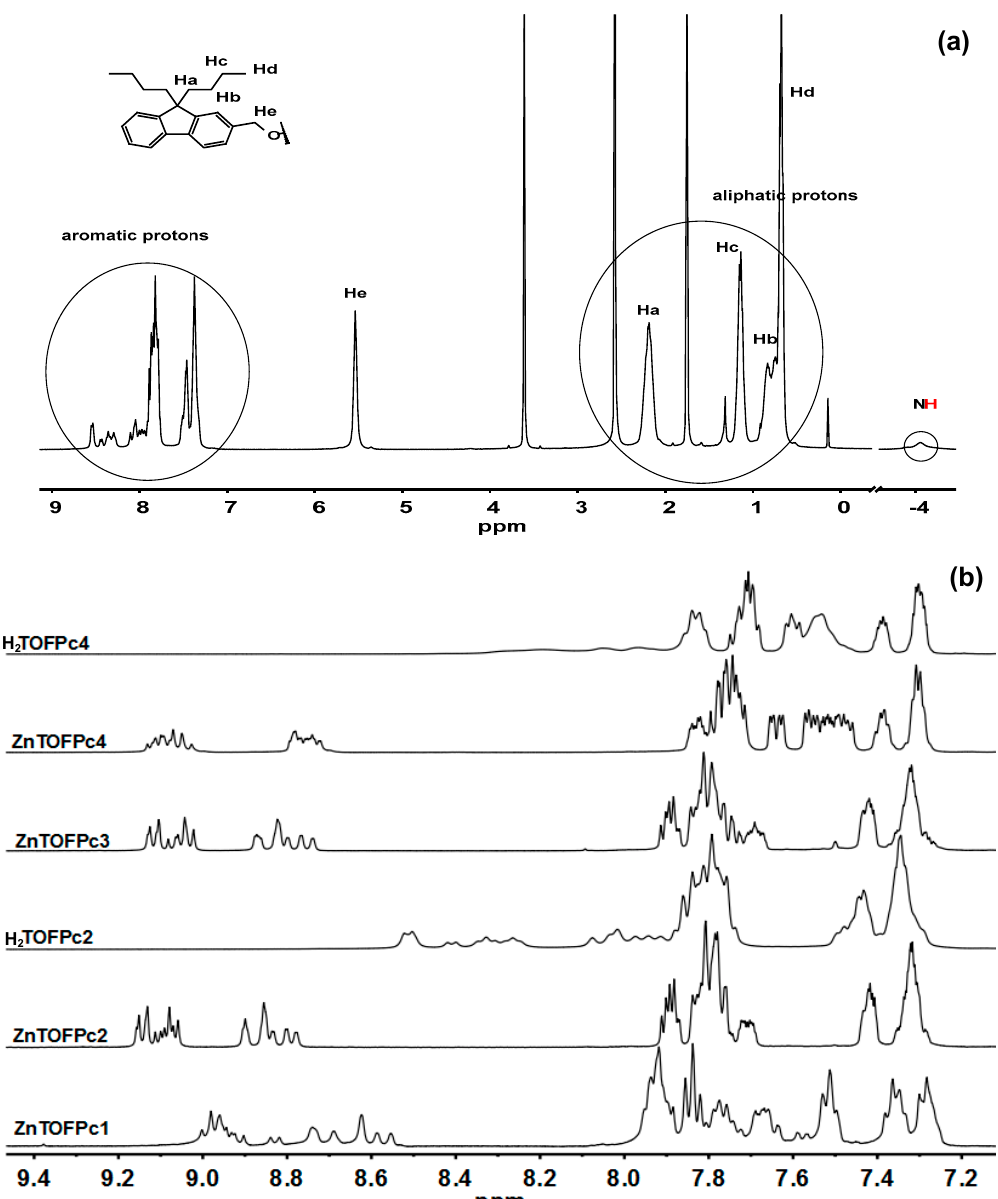
Figure 6. 1 H-NMR in THF-d 8 : ( a ) Complete spectrum of H 2 TOFPc2 . ( b ) Aromatic part of the 1 H-NMR spectra of ZnTOFPc1 – 4 complexes and free H 2 TOFPc2 and H 2 TOFPc4 , showing the presence of several positional isomers.